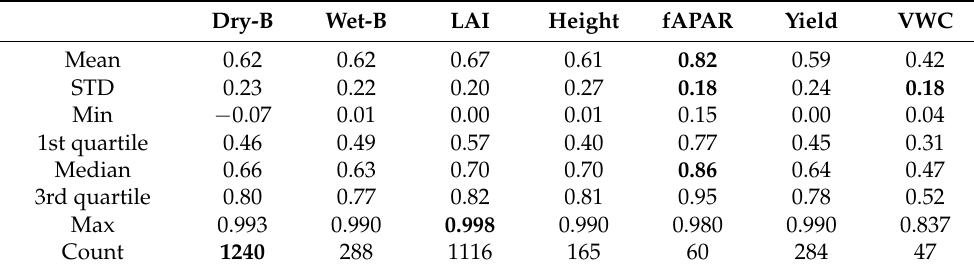
Figure 18. The coefficient of determination (R 2 ) of crop parameter estimation of screened studies (Dry-B: dry biomass; Wet-B: wet biomass; CH: crop height; VWC: vegetation water content). Table 7. Statistical analysis of R 2 in various crop biophysical parameters.